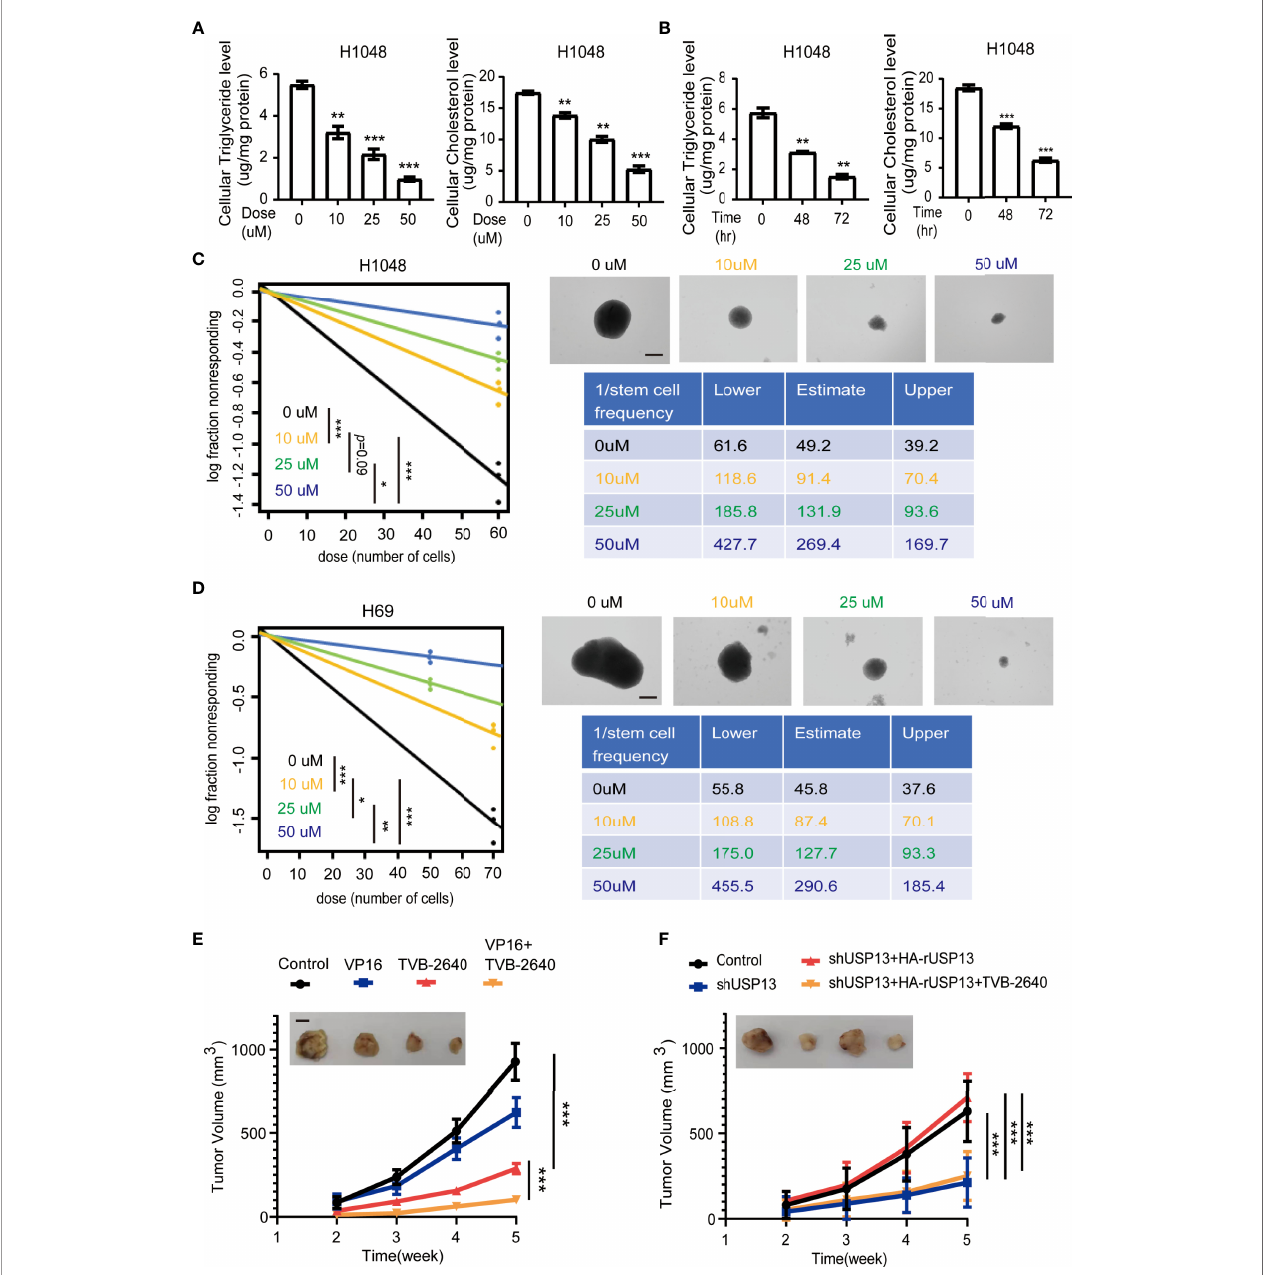
FIGURE 6 | FASN inhibition attenuates SCLC lipogenesis, self-renewal properties, chemotherapy resistance and USP13-dependent tumorigenesis. (A) Triglyceride (left) and cholesterol (right) levels were measured in H1048 cells treated with the FASN inhibitor TVB-2640 at the indicated doses for 72 hours. DMSO was used as the vehicle control. Data represent the means ± SD of triplicate samples. Two-tailed student ’ s t-test was used. ** p < 0.01, *** p < 0.001. (B) Triglyceride (left) and cholesterol (right) levels were measured in H1048 cells after 50 m M FASN inhibitor TVB-2640 treatment for the indicated periods of time. Data represent the means ± SD of triplicate samples. Two-tailed student ’ s t-test was used. ** p < 0.01, *** p < 0.001. (C, D) Left: ELDA was performed in H1048 (C) and H69 (D) cells with or without FASN inhibitor TVB-2640 treatment at the indicated dose. Representative sphere images (top right) and stemness frequency illustration of the cells with the upper and lower 95% con fi dence intervals (bottom right) are shown. Scale bars, 50 m m. Data represent the means ± SD of wells. Two-tailed student ’ s t-test was used. * p < 0.05, ** p < 0.01, *** p < 0.001. (E) Nude mice were subcutaneously injected with H69AR cells and intraperitoneally injected with indicated drugs when the size of the tumor reached approximately 100 mm 3 . Tumor sizes and volumes were measured and calculated (n=5 per group). Data represent the means ± SD of fi ve mice per group. Two-tailed student ’ s t-test was used. * p < 0.05, ** p < 0.01, *** p < 0.001. (F) H1048 cells with or without USP13 depletion, or shUSP13 cells combined with reconstituted expression of WT HA-rUSP13 were subcutaneously injected into nude mice and then with or without TVB-2640 treatment. Tumor sizes and volumes were measured and calculated (n=5 per group). Data represent the means ± SD of fi ve mice per group. Two-tailed student ’ s t-test was used. ns, not signi fi cant. *** p <